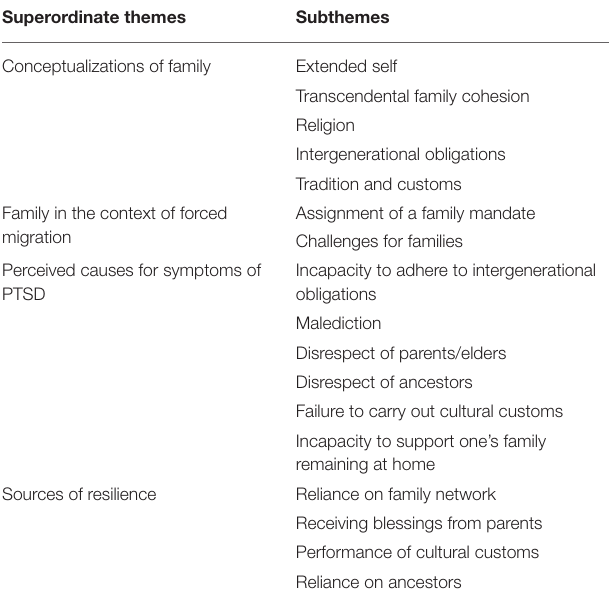
TABLE 3 | Structured presentation of the themes and subthemes of the interpretative phenomenological analysis. Superordinate